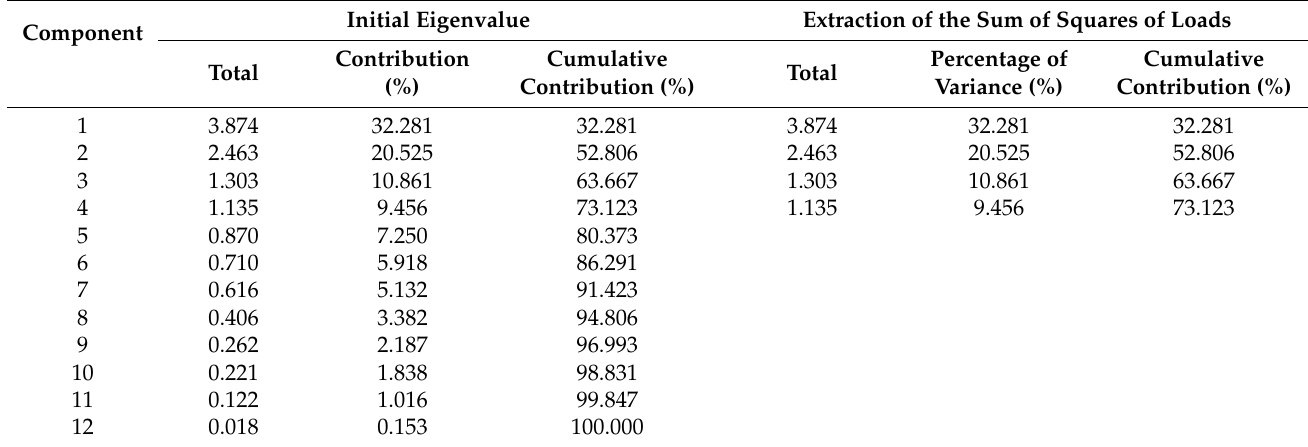
Table 4. Eigenvalues and contribution rates of principal components.